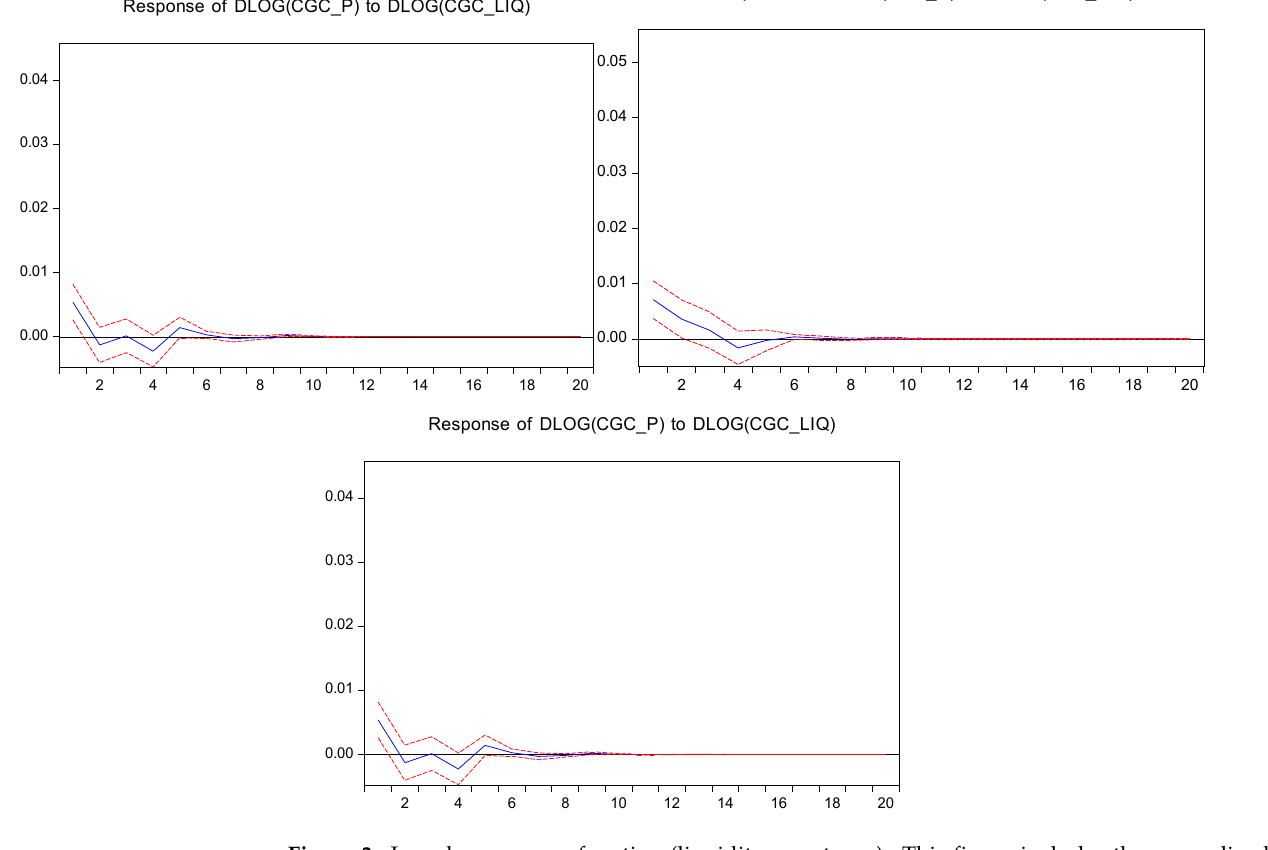
Figure 2. Impulse response function (investors’ attention → returns). This figure includes the gen- eralized impulse response function in vector autoregressive (VAR) models studying the response of cannabis stock returns to shocks to investors’ attention.